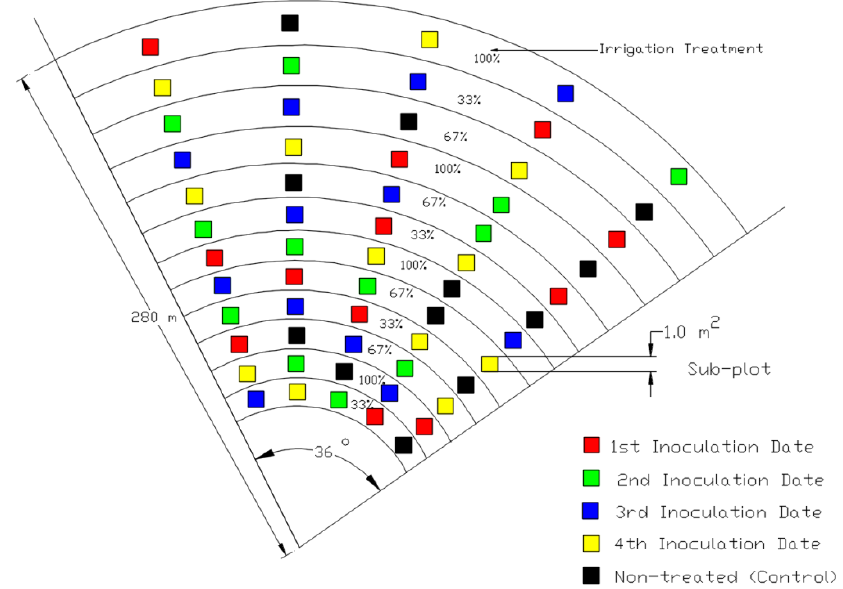
Figure 1. Wheat experiment plot design layout in